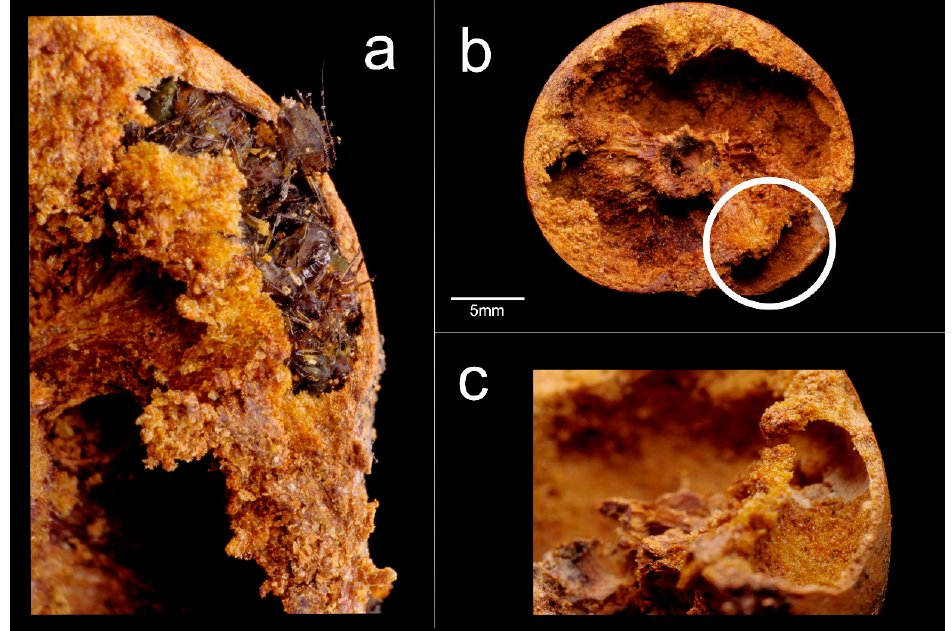
Figure 10. ( a ) Aphids inside the chamber in a Qwba gall nest of C. scutellaris —all aphids were still alive at the moment of checking; ( b ) section of the gall showing the chamber’s elongated shape, highlighted by the circle; ( c ) detail of the entrance hole connecting the aphid chamber to the rest of the excavated area occupied by the ants.